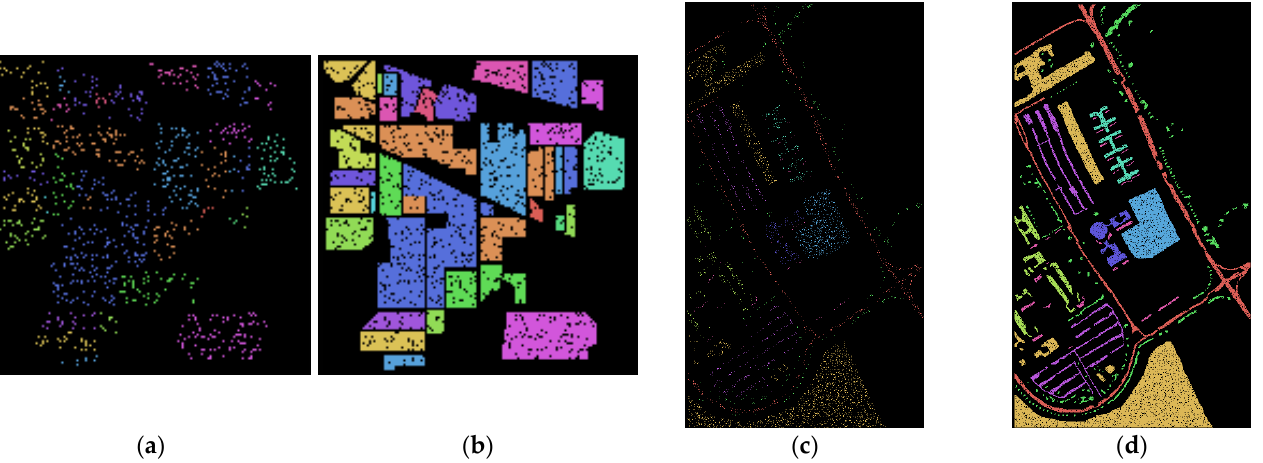
Figure 7. The training set and test set of two datasets. ( a , c ) are the training sets. ( b , d ) are the test sets.